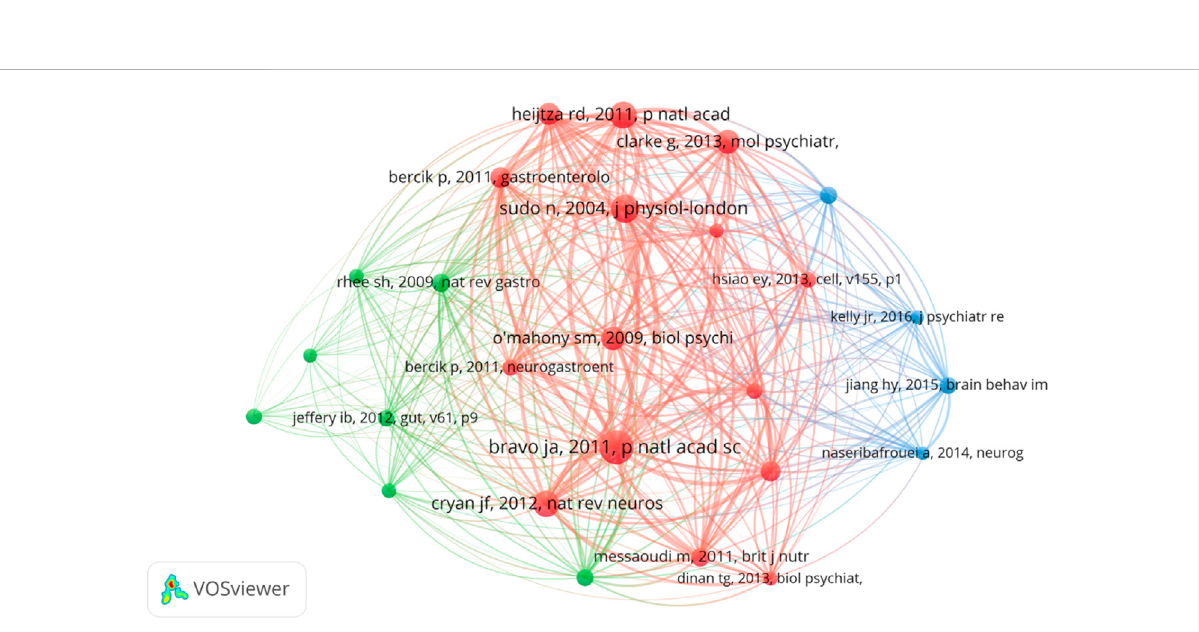
FIGURE 6 Visualization of a clustering map of highly cited